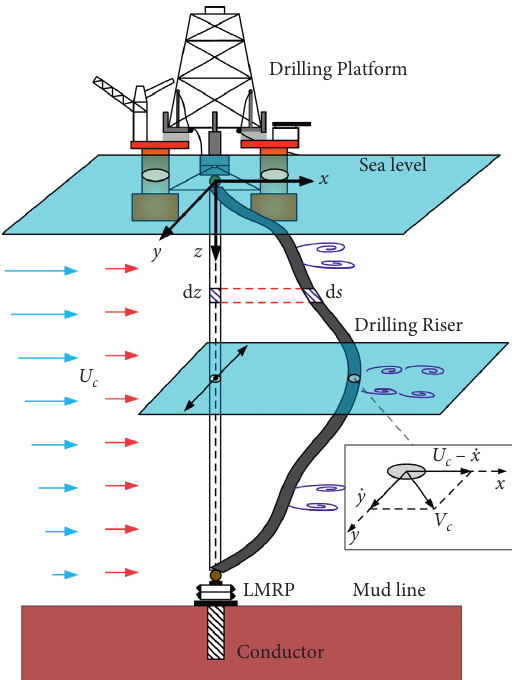
Figure 1: Schematic of a marine